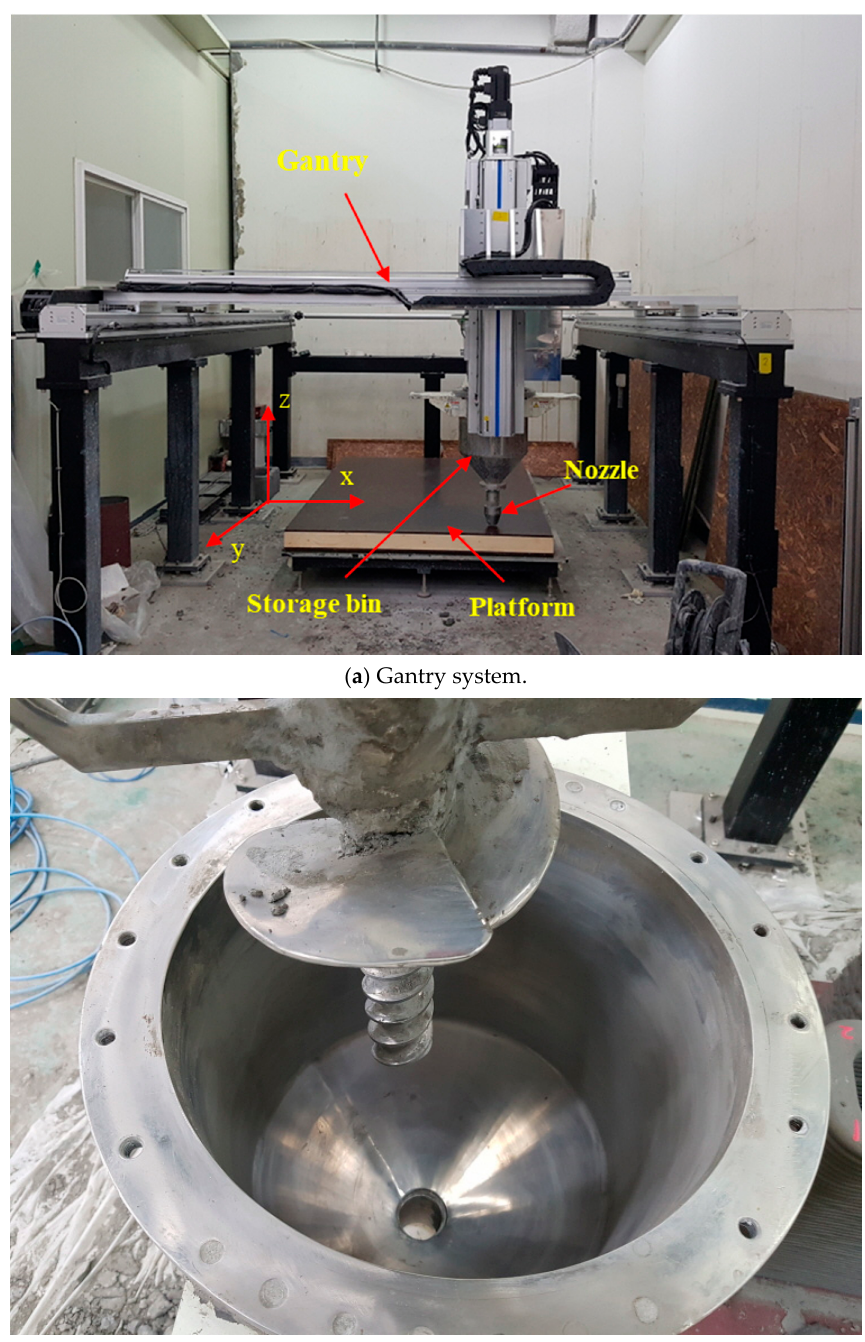
Figure 1. 3D printing equipment.